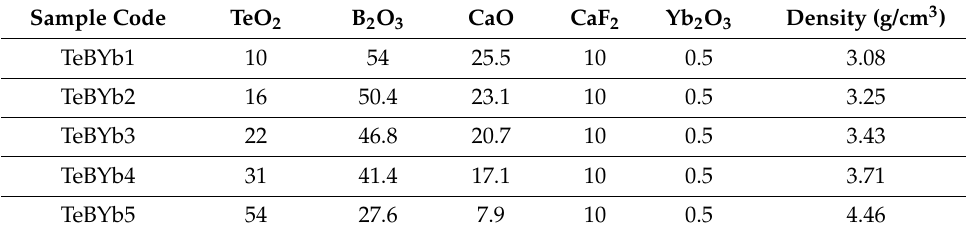
Figure 7. The effective atomic number for the TeBYbX glasses. Table 1. Samples’ codes, composition (mol%) for the TeBYb-X